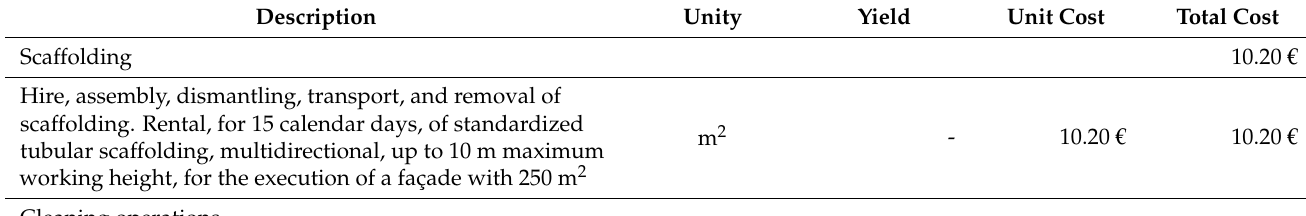
Table 1. Cost of cleaning operations in